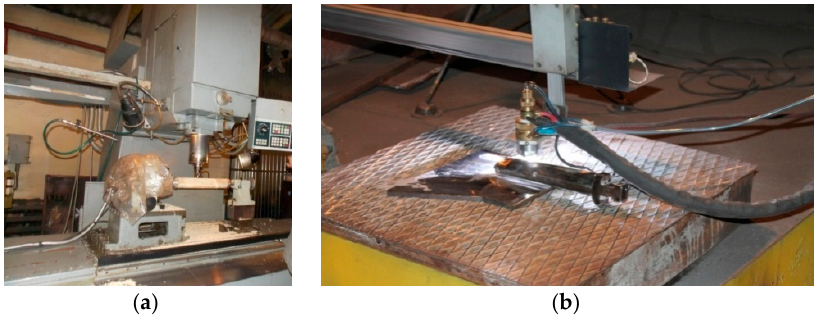
Figure 4. Treatment process: ( a ) manufacturing of a steam turbine blade implant on the 2E450 machine; ( b ) microplasma welding process.